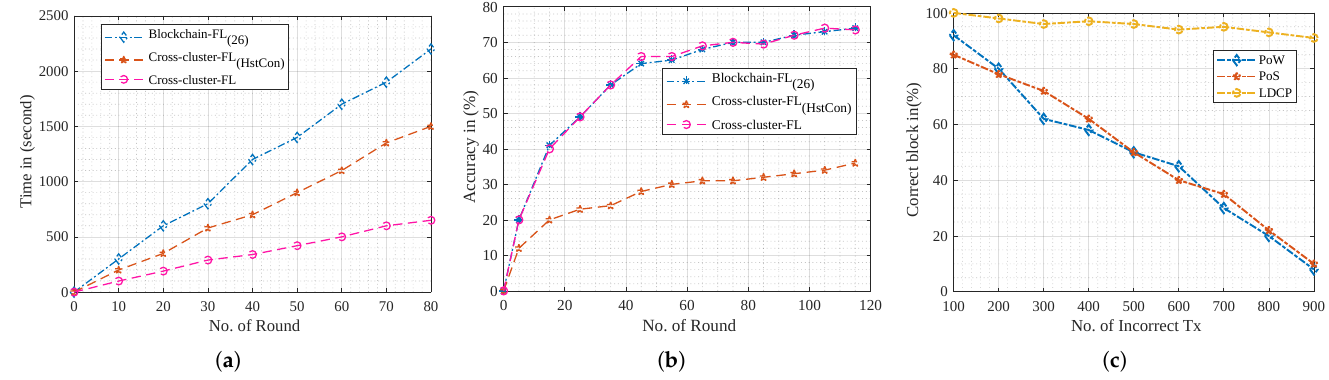
Figure 10. Performance Evaluation of the case-study. ( a ) System latency of different approaches. ( b ) Accuracy of model performance. ( c ) Trust percentage of consensus mechanism against fake